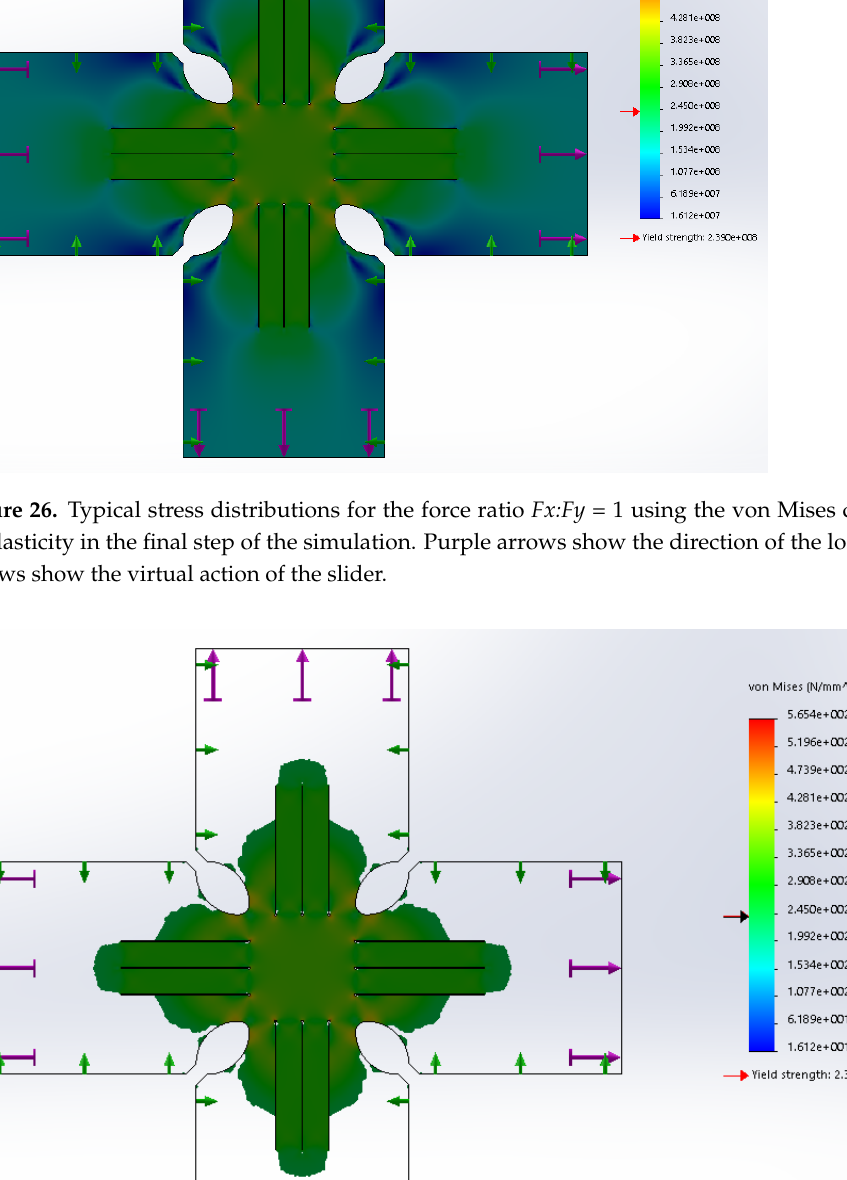
Figure 28. On the left, stress distributions SX on the x-axis are equal to 𝜎 (cid:3051) , and on the right, stress distributions SY on the y-axis are equal to 𝜎 (cid:3052) using von Mises condition . Purple arrows show the direction of the load; green arrows show the virtual action of the slider.